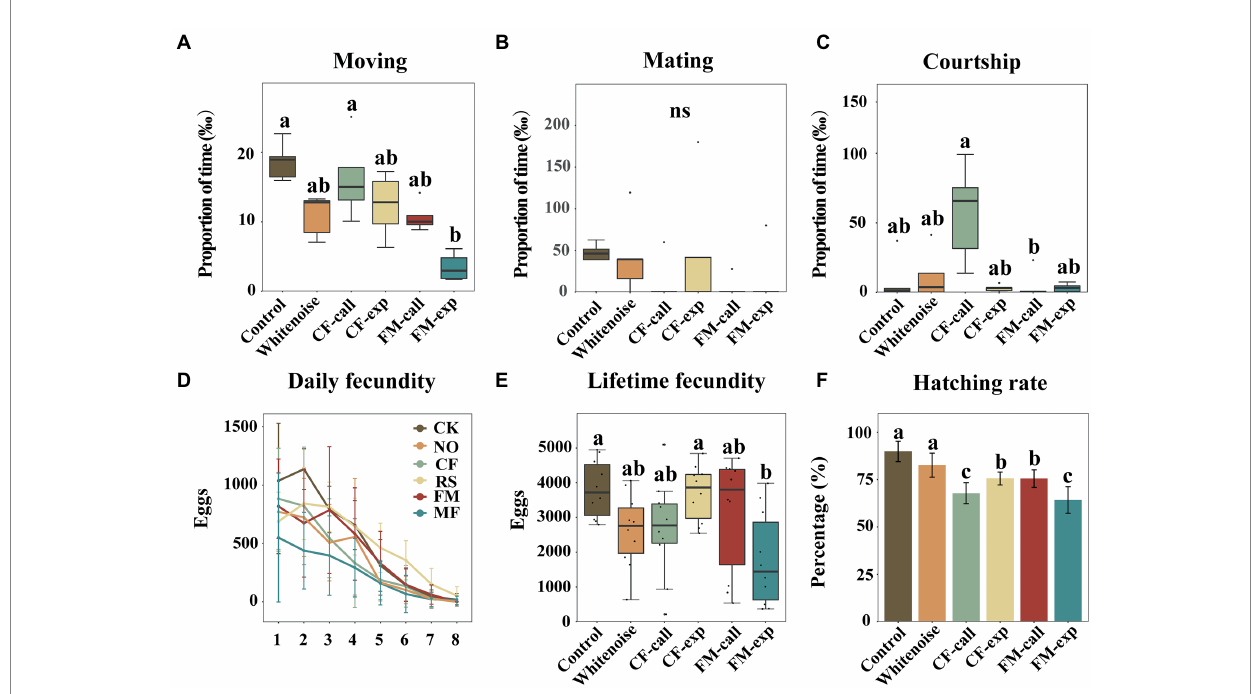
FIGURE 2 Reproductive behavior and fecundity of S. litura moths under different types of predation risk. (A) The proportion of time spent moving, (B) the proportion of time spent mating, (C) the proportion of time spent courting, (D) daily fecundity, (E) lifetime fecundity, and (F) the hatching rate. The data are expressed as the mean ± SD. Different letters on the bars or box plots indicate significant differences between treatments (Tukey’s test, p < 0.05); ns indicates no significant difference between